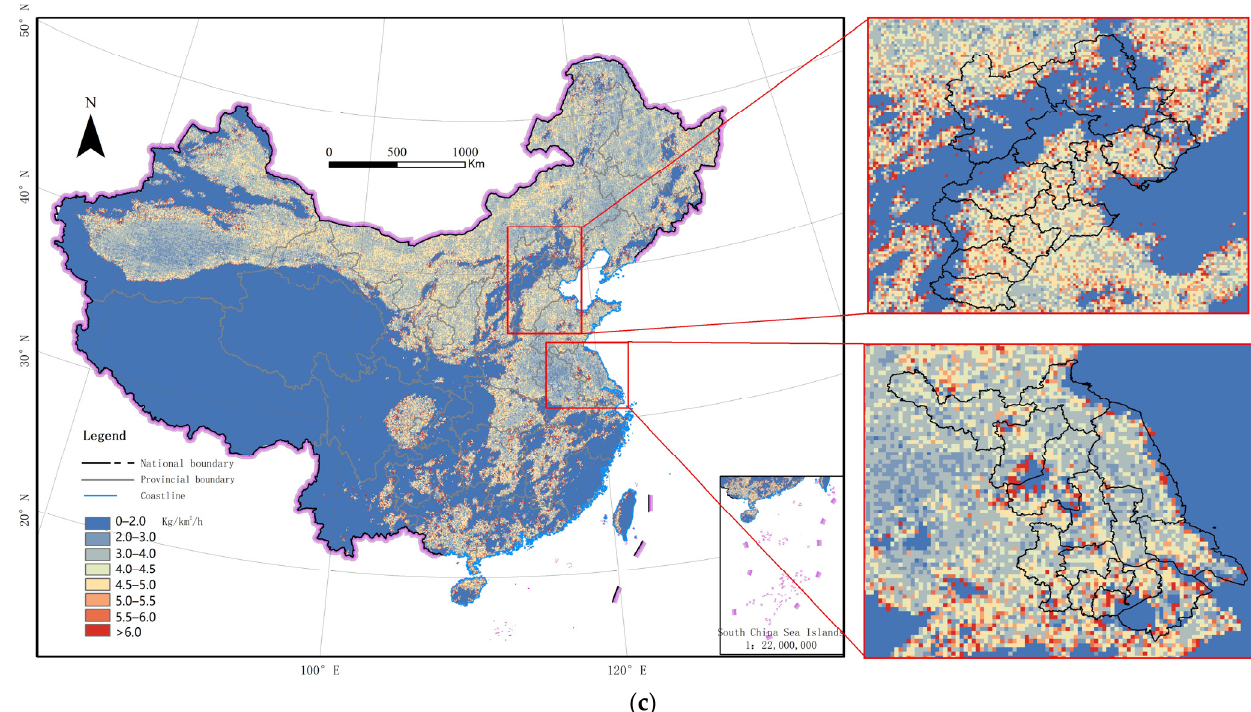
Figure 4. ( a ) Surface spatial distribution of averages CH 4 of divergence over China from March 2019 to September 2022. ( b ) Number of observations on that grid over China from March 2019 to September 2022. ( c ) The estimated CH 4 emissions are based on ( a ).